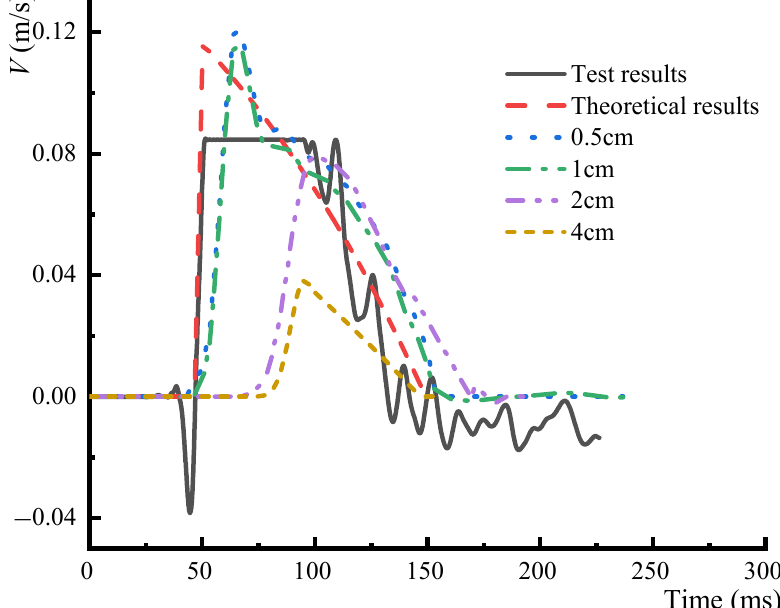
Figure 11. The effects of grid size on the computed velocity–time curve.